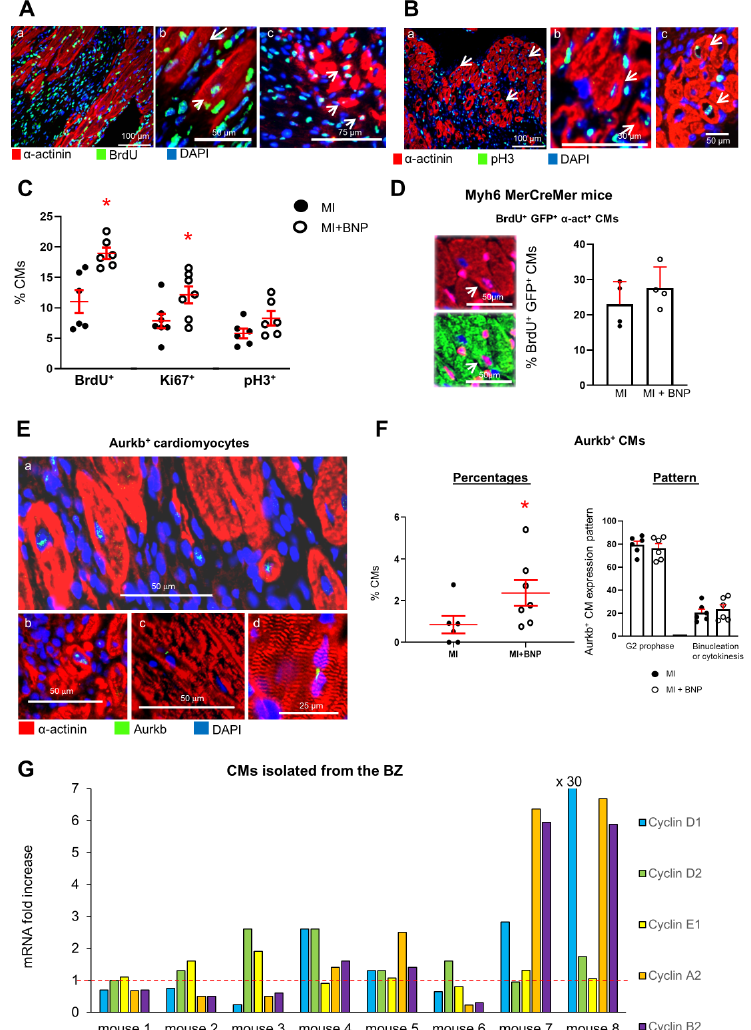
Figure 3. BNP treatment stimulates cardiomyocyte cell cycle re-entry in the infarct and border area of the hearts 10 days after infarction. ( A , B ) Representative pictures of immunostainings allowing the detection of CMs (i.e., α actinin + cells) expressing BrdU or phospho histone 3 (pH3) in BNP-treated infarcted hearts. ( A ( b , c ), B ( b , c )): High magnification with examples of dedifferentiated CMs expressing BrdU or pH3. × 10: magnification. ( C ): Percentages of CMs (positive CMs/total number of α actinin + cells) expressing proliferative markers in the ZI + BZ of infarcted hearts. For each heart, at least 10 pictures are analyzed. n = 6 different saline- and BNP-treated infarcted hearts. ( D ): BrdU incorporation assessed among GFP + CMs (i.e., α actinin + cells) in the infarction area of BNP-treated Myh6 MerCreMer hearts. Mice injected 2 weeks before infarct with tamoxifen in order to induce GFP expression specifically in CMs. At least 50 pictures were analyzed for saline- and BNP-treated mice originating from 4 different mice per group. The number of BrdU + GFP + CMs is related to the total number of CMs. ( E ): Representative pictures of immunostainings allowing the detection of CMs (i.e., α actinin + cells) expressing the Aurora B proliferative marker in the ZI+BZ of BNP-treated hearts. Aurkb was mainly localized in the nuclei ( E ( a , b )) which characterized CMs undergoing prophase. CMs undergoing binucleation or cytokinesis were also detected ( E ( c , d )). ( F ) Percentages of CMs expressing Aurora B. For each heart, at least 10 pictures are analyzed. n = 6 different saline- and 7 BNP-treated infarcted hearts. Depending on Aurora B localization, the pattern of Aurkb + CMs was determined on 6 different hearts per group. At least 40 Aurora B + CMs are analyzed per heart. ( G ) mRNA expression coding for cyclin genes D1, D2, E1, A2 and B2. Results of CMs isolated from the BZ of 8 different BNP-treated infarcted hearts. Results expressed as the fold increase above the levels in CMs isolated from saline-treated infarcted hearts (represented by the red dotted line, n = 9 different saline-treated infarcted hearts). ( C , D , F ) Individual values represented and the means ± SEM represented in red. * p <